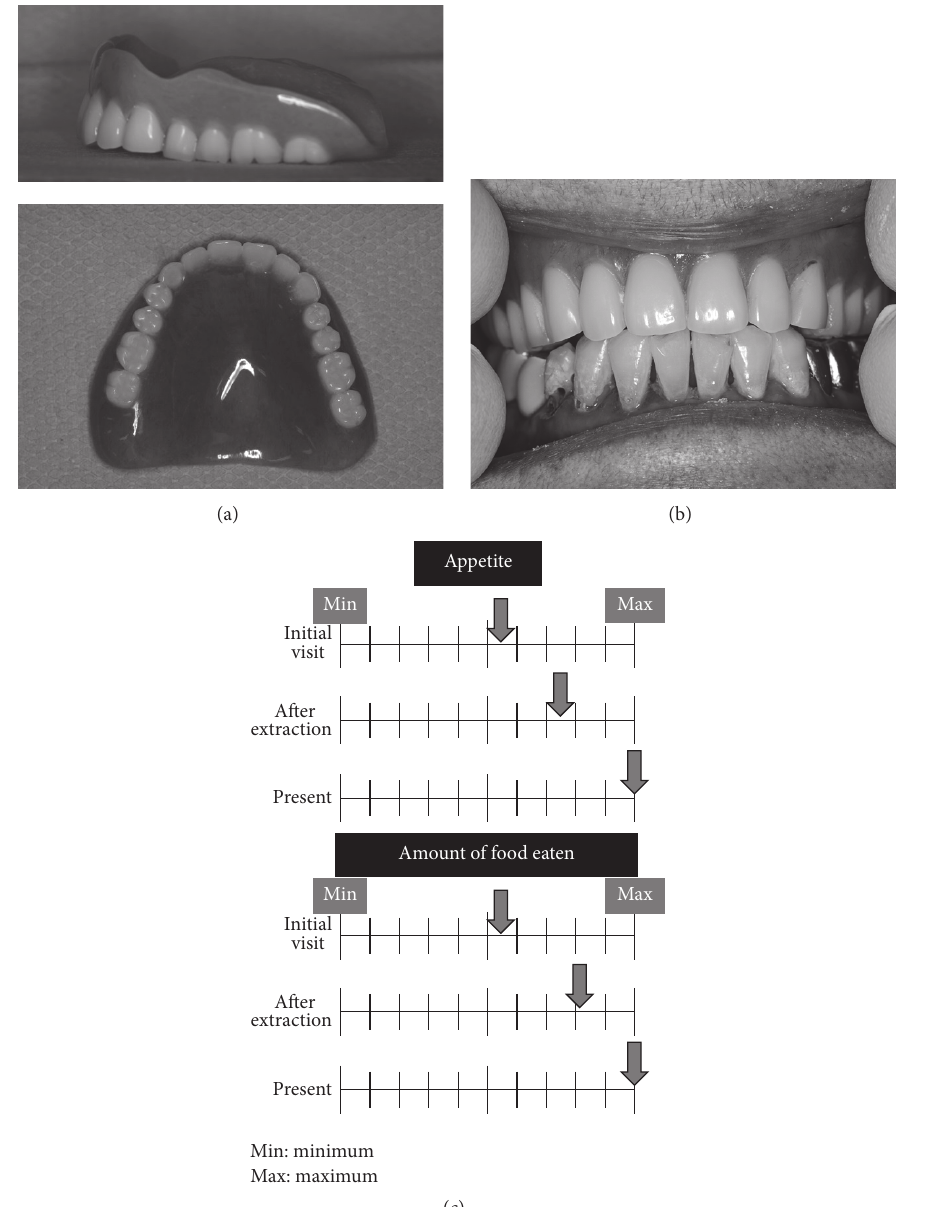
Figure 2: (a) Lateral and occlusal views of the complete maxillary denture. (b) Frontal view of the complete maxillary denture. (c) Visual analogue scale of appetite and amount of food eaten at the time of the initial visit, after extraction, and posttreatment, drawn by the patient’s